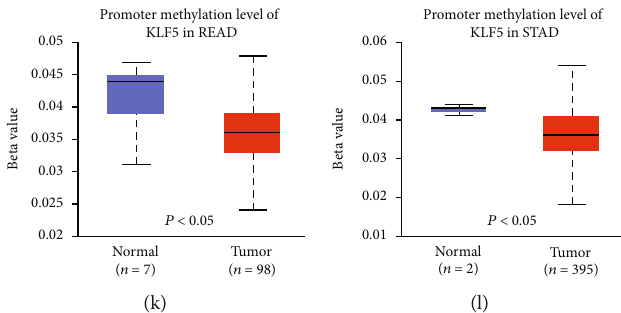
Figure 2: In ESCA and STAD, KLF4 expression is related to drinking frequency or Helicobacter pylori infection. The promoters of KLF4 and KLF5 genes are hypomethylated in READ and STAD. (a – d) Expression of KLF4 and KLF5 based on drinking frequency or Helicobacter pylori infection. (e – l) The methylation status of KLF4 and KLF5 promoters in gastrointestinal tumors.